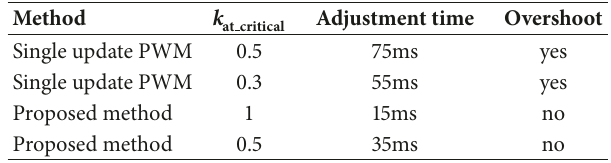
Table 5: The steady state experimental results of grid currents. Table 6: The dynamic experimental results of grid